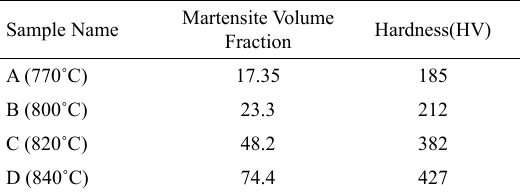
Table 2. Martensite volume fraction and hardness of specimens with temperature.